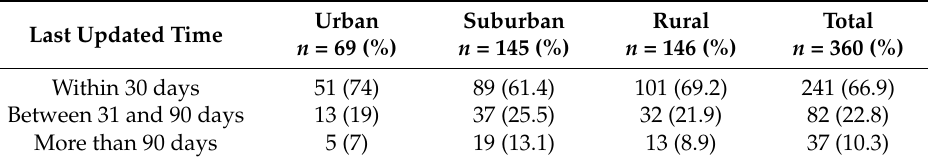
Table 3. Last updated time on websites of 360 LHCs in